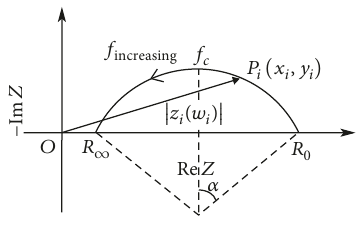
Figure 3: The Cole-Cole plot